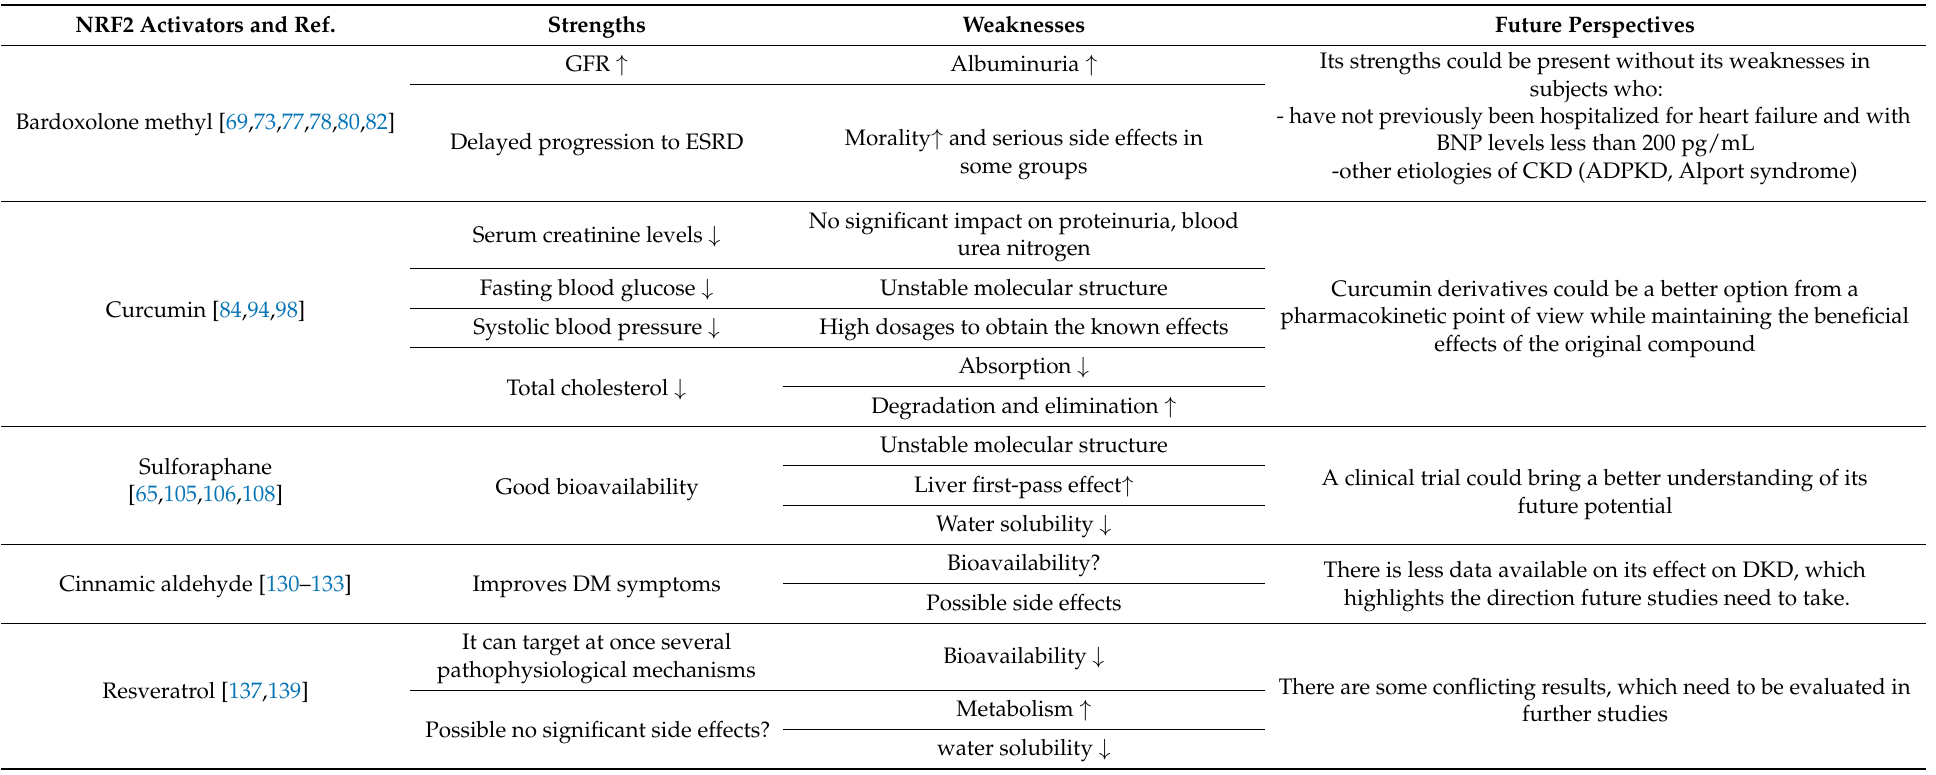
Table 1. Key points of the most relevant NRF2 activators and future view of their use in CKD. NRF2 Activators and